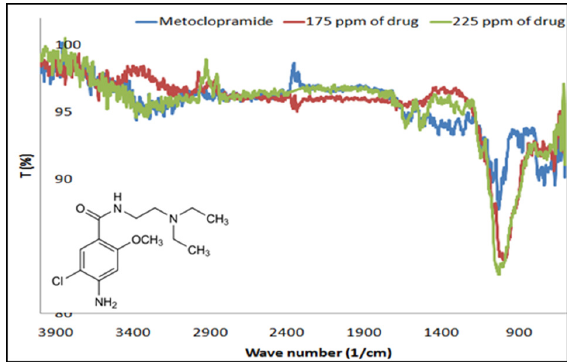
Fig. 7. FTIR spectra of drug (a) and film formed after adsorption on steel surface